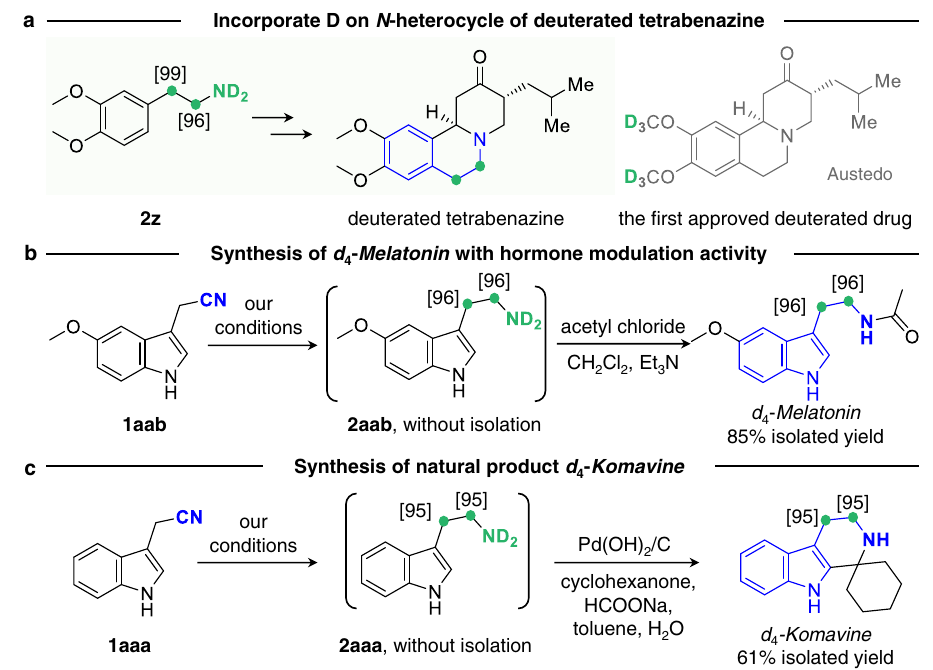
Fig. 6 | Potential utility for synthesizing deuterated drugs from obtained α , β - DAEAs. a An alternative route to complement the fi rst US FDA-approved